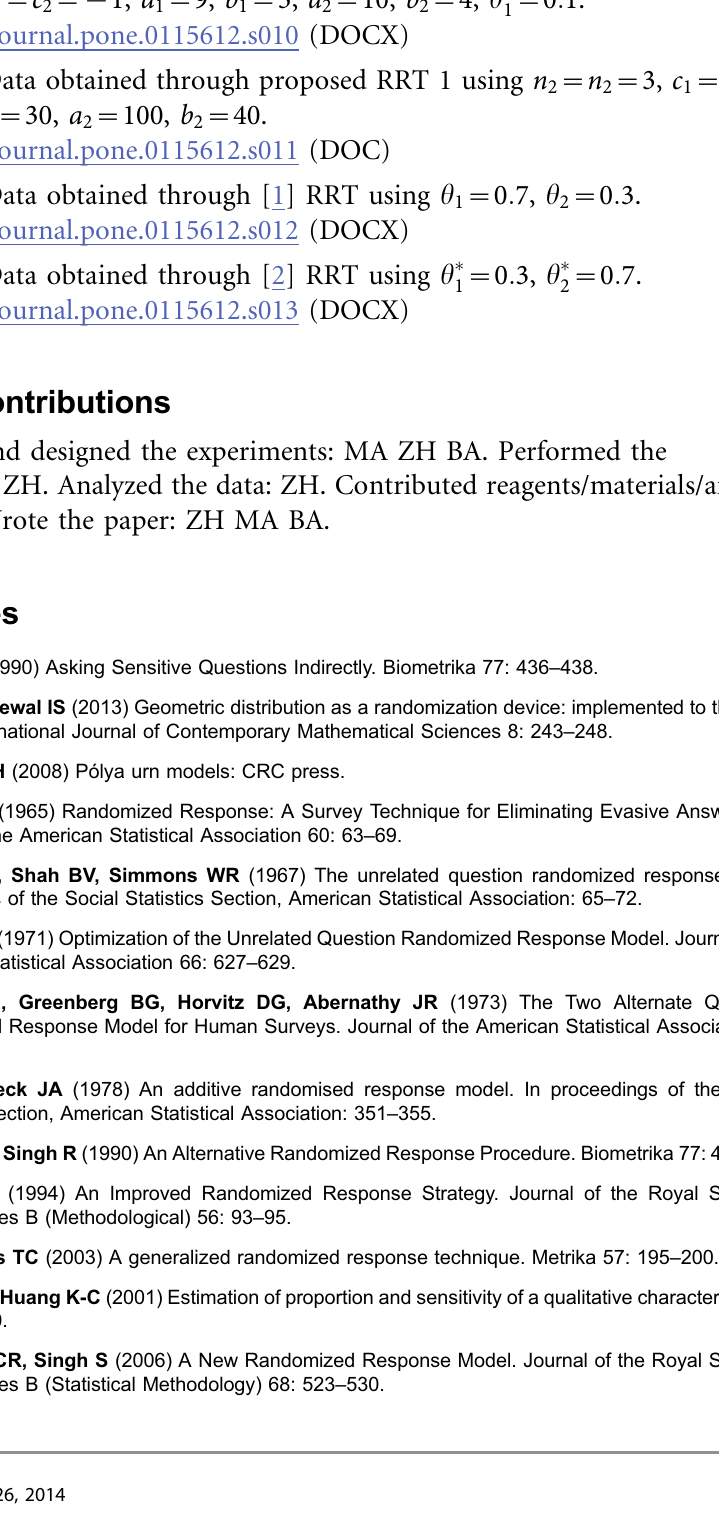
( in bold ) ^ p 1 ( in bold ) ^ p 1 ~ 40 . 2